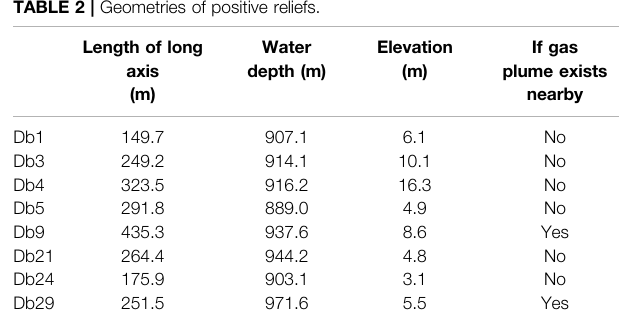
TABLE 2 | Geometries of positive reliefs. Length of long